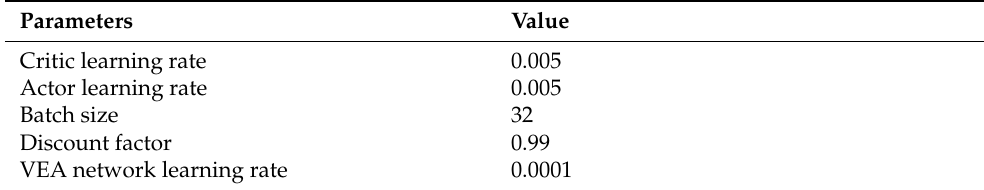
Table A1. Parameter setting in StarCraft